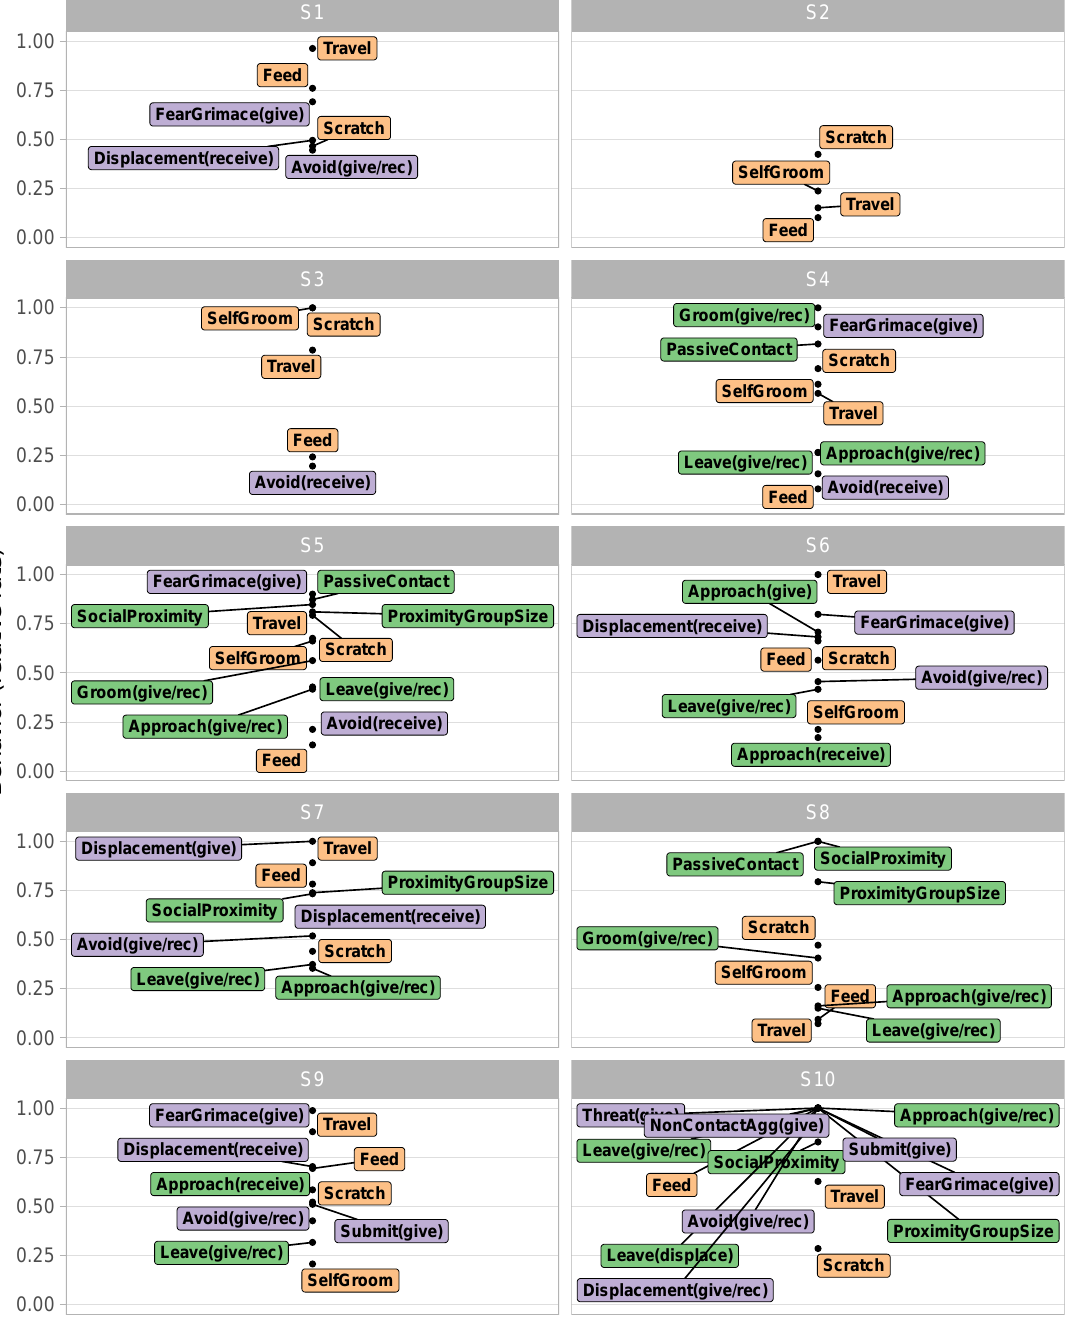
Figure 3. The content of behavioral states fit by the model. Relative rates for each behavior are calculated by dividing the posterior mean rates across states by the mean rate of the highest state, such that 1 represents the highest mean rate across states. For visual clarity, behaviors with relative rates below 0.05 are omitted, and behaviors for which the difference between the “give” and “receive” variants is less than 0.33 are concatenated into a single label